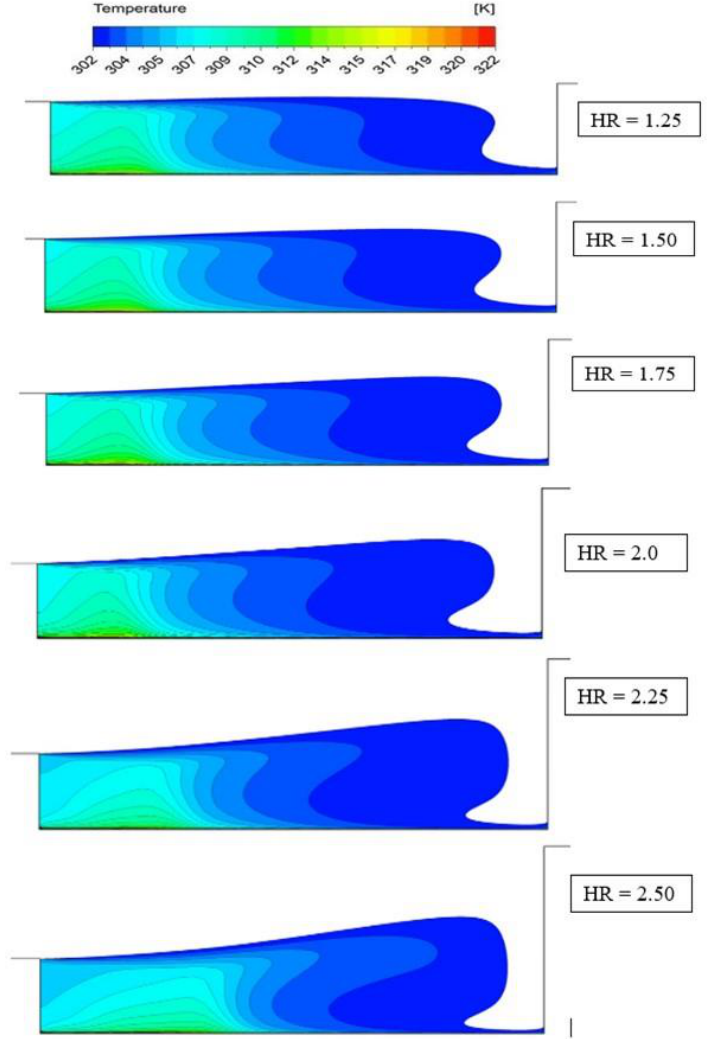
Figure 14. Temperature contours in a plane of symmetry for cavity at different height ratios (1.25 ≤ HR ≤ 2.5).